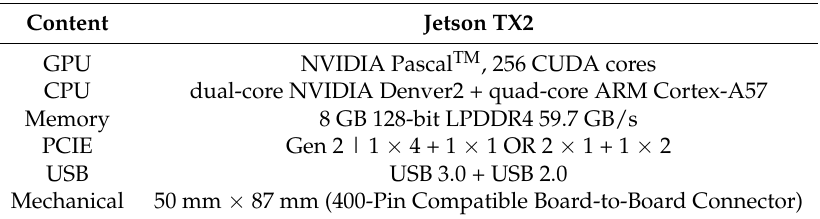
Table 4. The NVIDIA Jetson